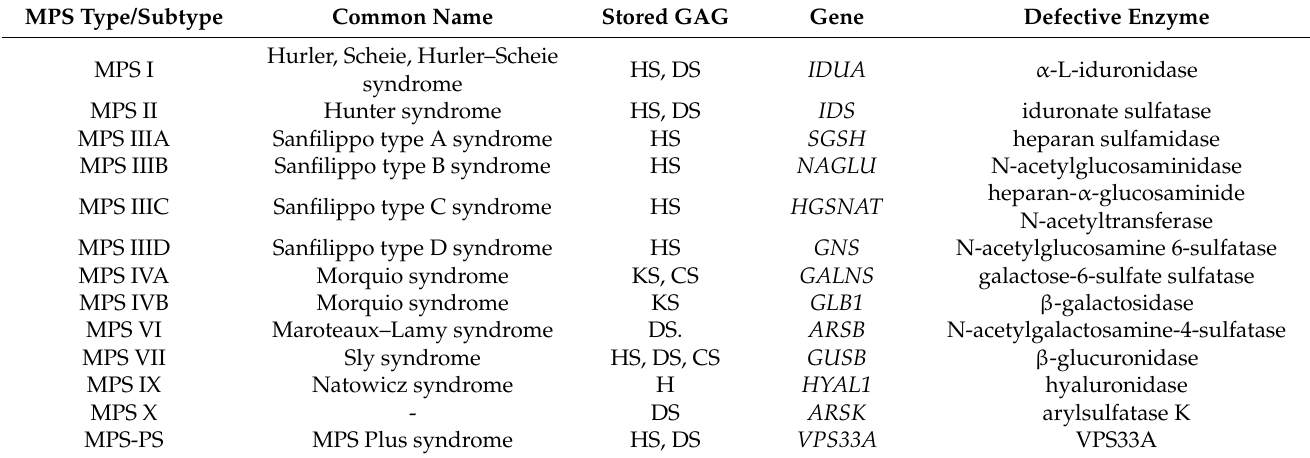
Table 1. Characteristics of MPS types/subtypes (based on ref. [16], with permission of the